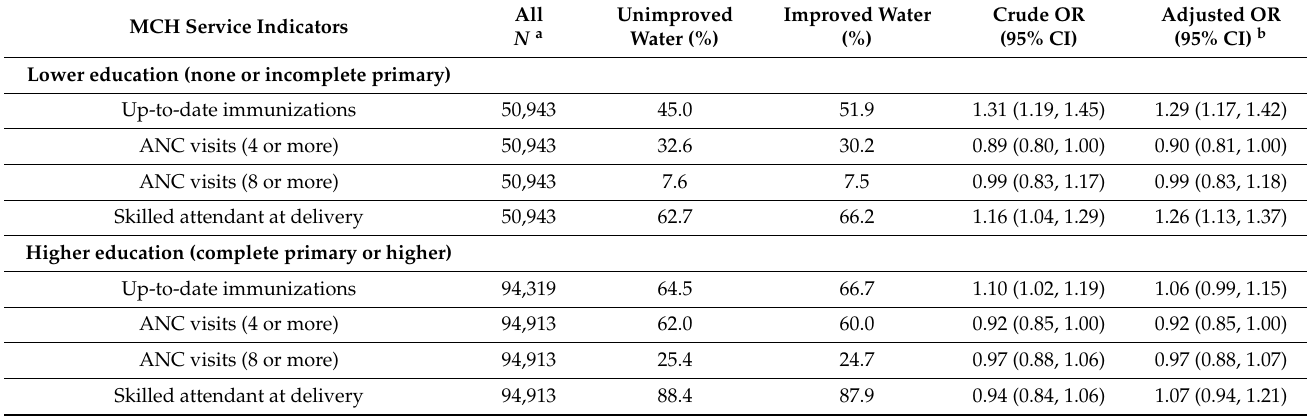
Table 4. Associations between improved (vs. unimproved) water sources and indicators of maternal and child health care service utilization stratified by maternal